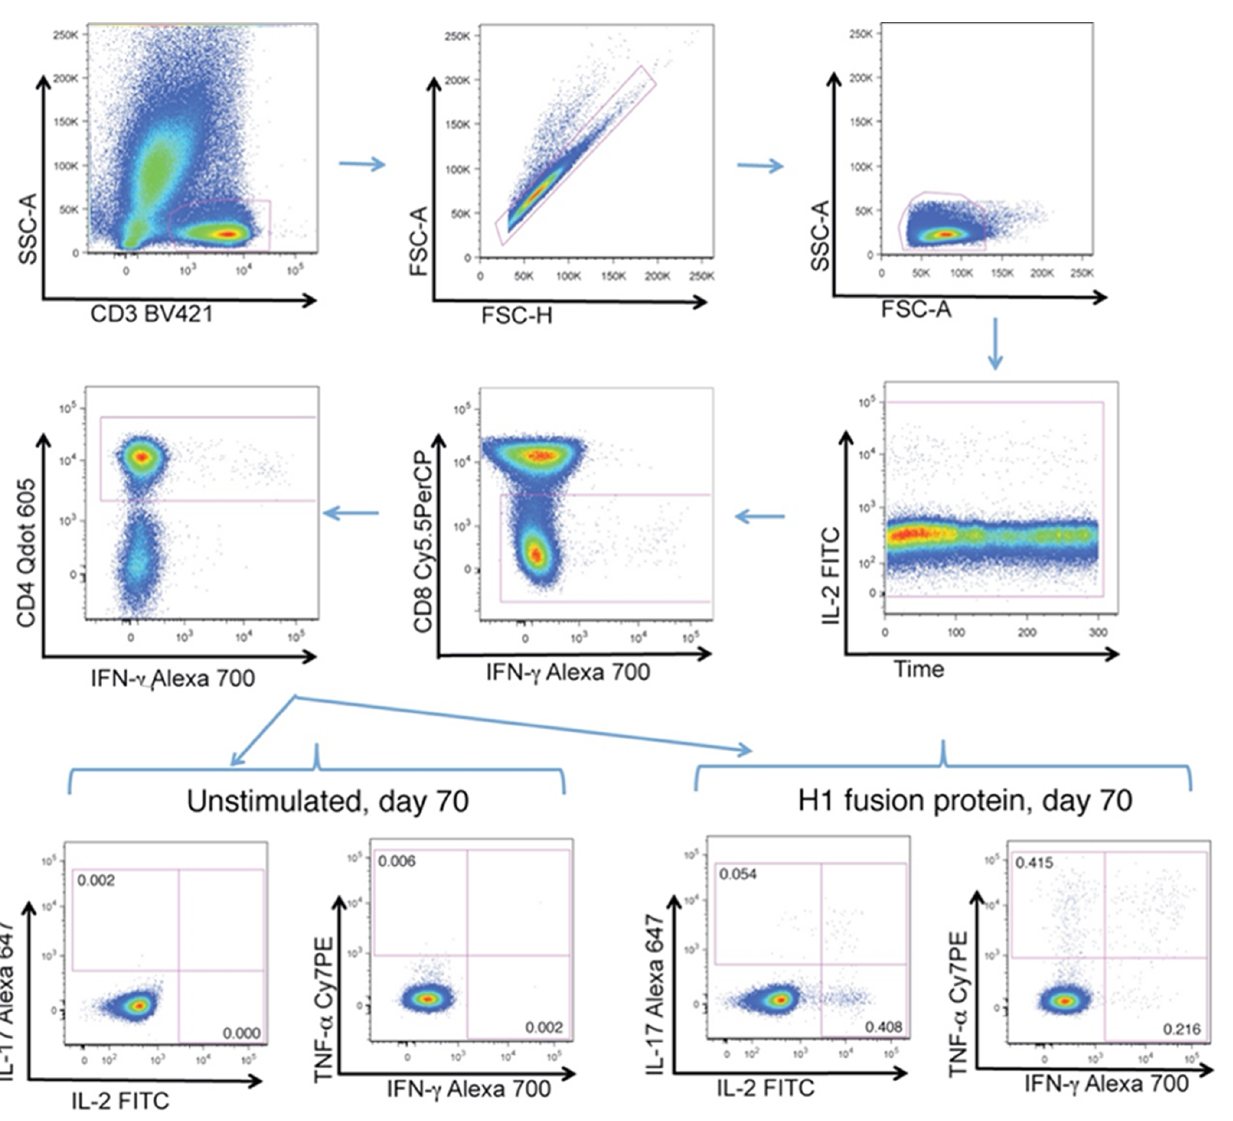
Fig. 2. Gating strategy used for flow cytometric analysis of H1-induced Tcell cytokine expression. The plots show sequentially the gating hierarchy of one representative sample: CD3 + Tcells, single cells, lymphocytes, time, CD8-Tcells, which were further gated for CD4 + cells. The plots on the lowest row include the cytokine expression gates for either unstimulated or H1 fusion protein stimulated PBMC at day 70 divided in the co-expression of IL-17 and IL-2 or TNF- a and IFN- c by CD4 + T cells.